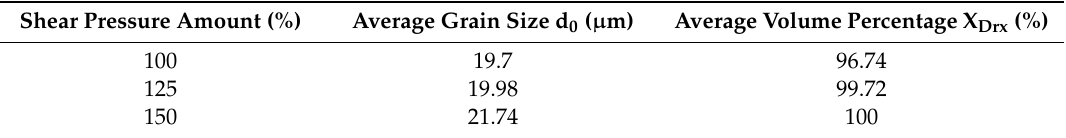
Table 7. Tracking point dynamic recrystallization grain size and volume percentage